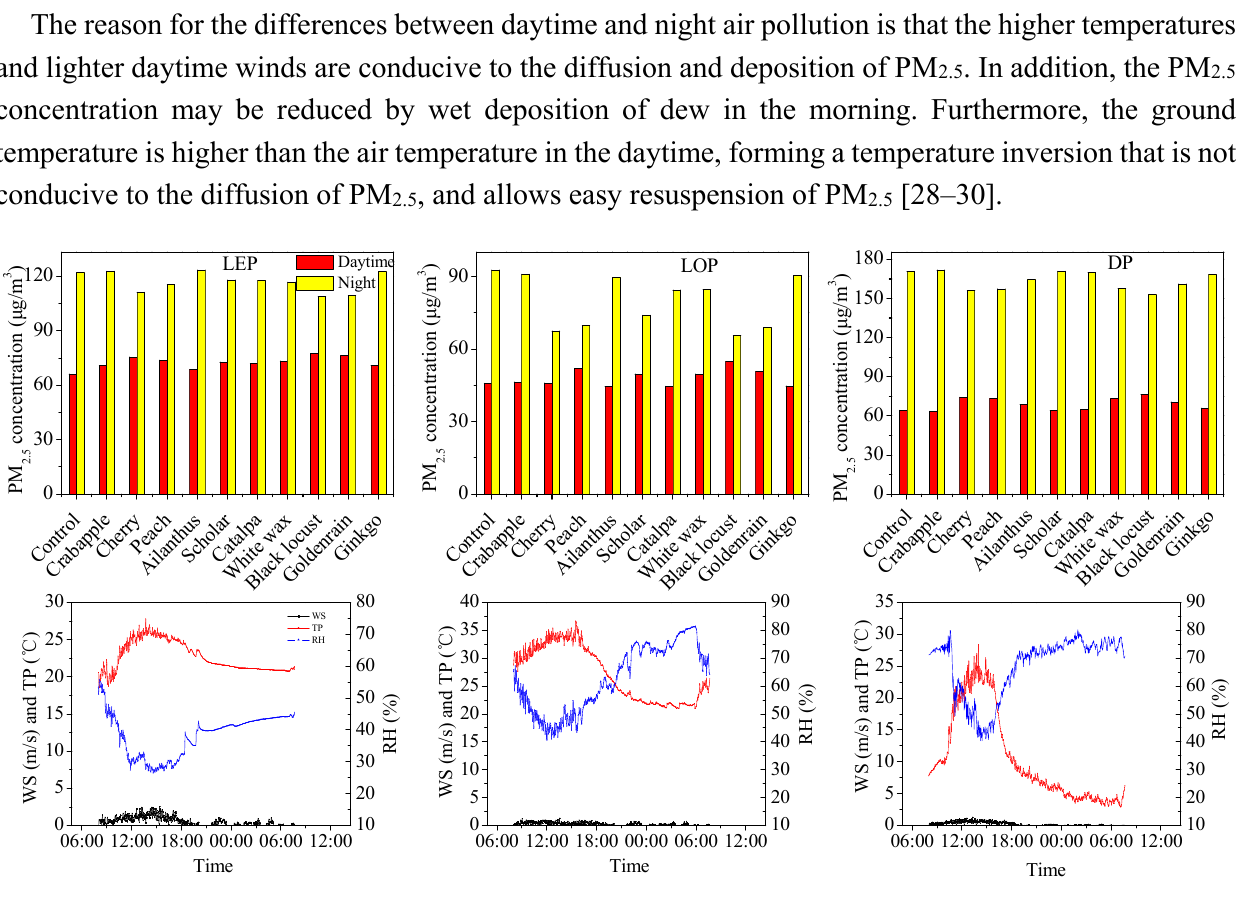
Figure 2. Average PM 2.5 concentration of 10 forest types and the control area in three leaf growth periods and differing climatic